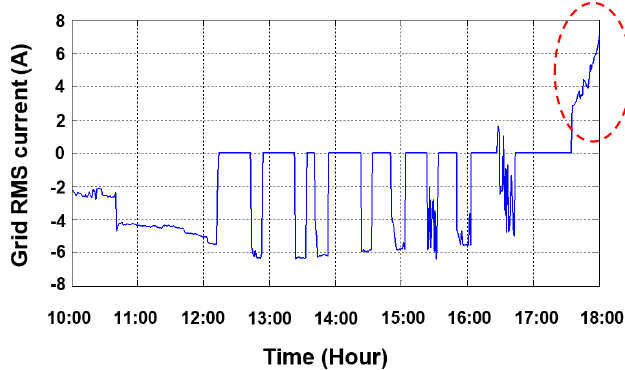
Figure 19. Fuzzy-based EMS in sunny day: ESS SOC.